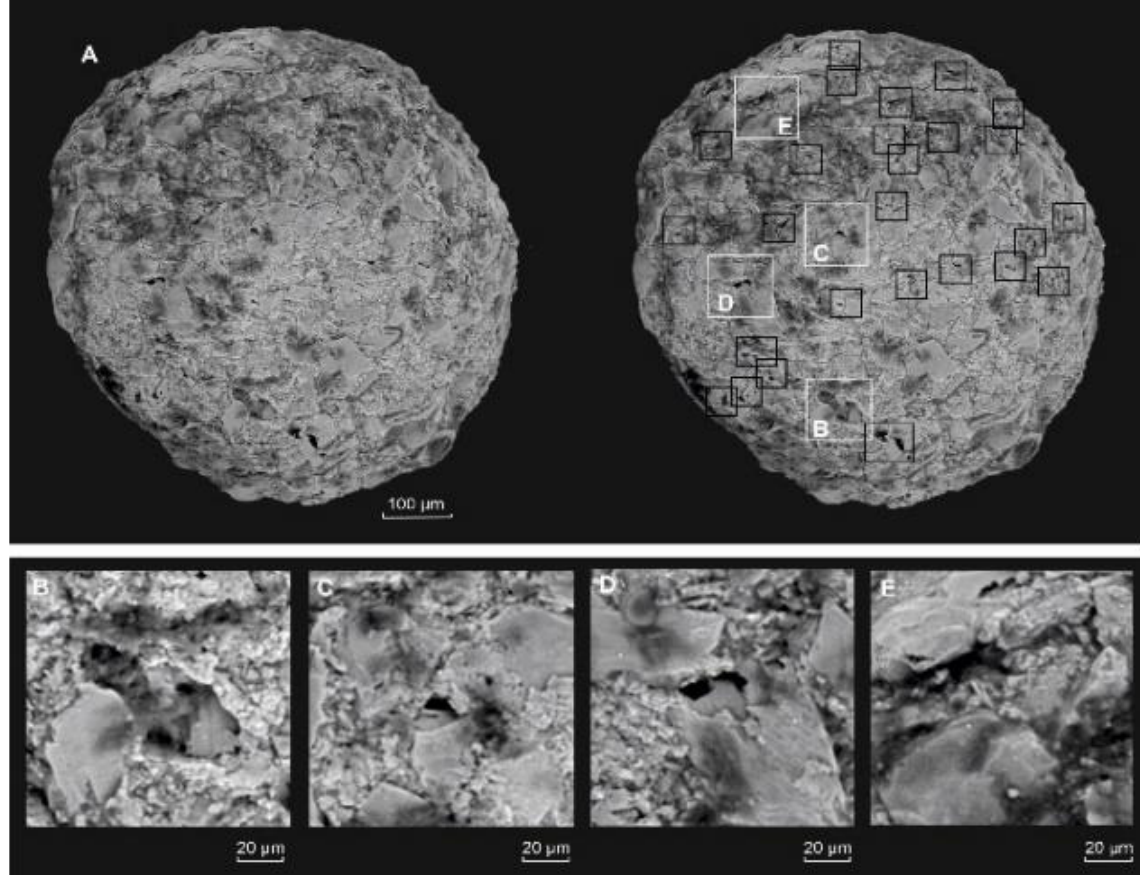
Figure 1A . SEM picture of Orbulinelloides agglutinatus holotype specimen. 1B. pores within the test (locations of enlarged photos are marked with white squares). Black squares indicate the position of pores. 1C-E. Details of